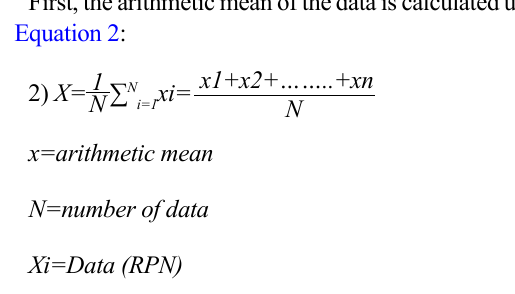
Figure 1. Flowchart of steps for describing and assessing risk by the FMEA method Figure 1 . Flowchart of Steps for Describing and Assessing Risk by the Failure Mode and Effects Analysis (FMEA) Method Table 1 . Ranking of Error Probability Occurrence